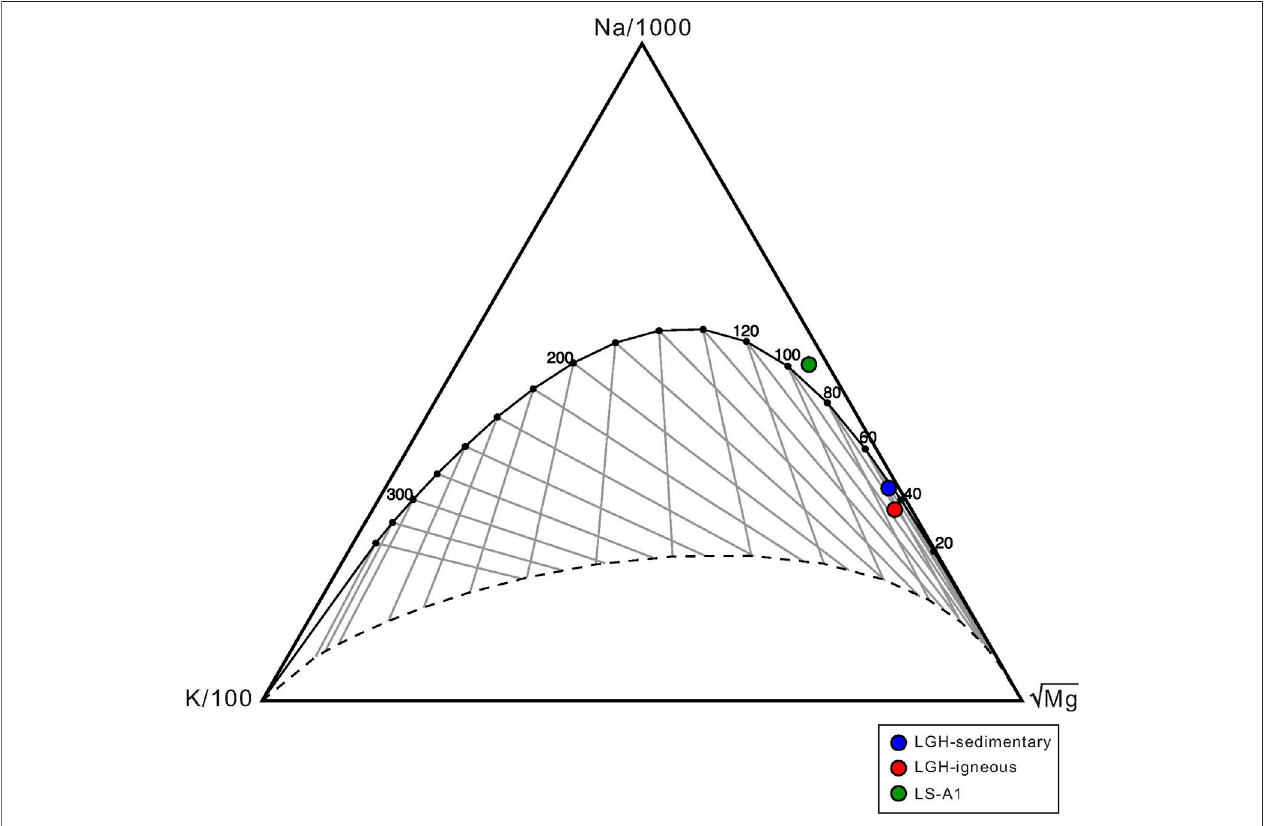
FIGURE 9 | Plot of Giggenbach Na-K-Mg ternary diagram. Solid curve denotes full equilibrium and dash line denotes lower limit of partial equilibrium. Two end members in MV LGH as well as MV LS-A1 fall on or close to full equilibrium.